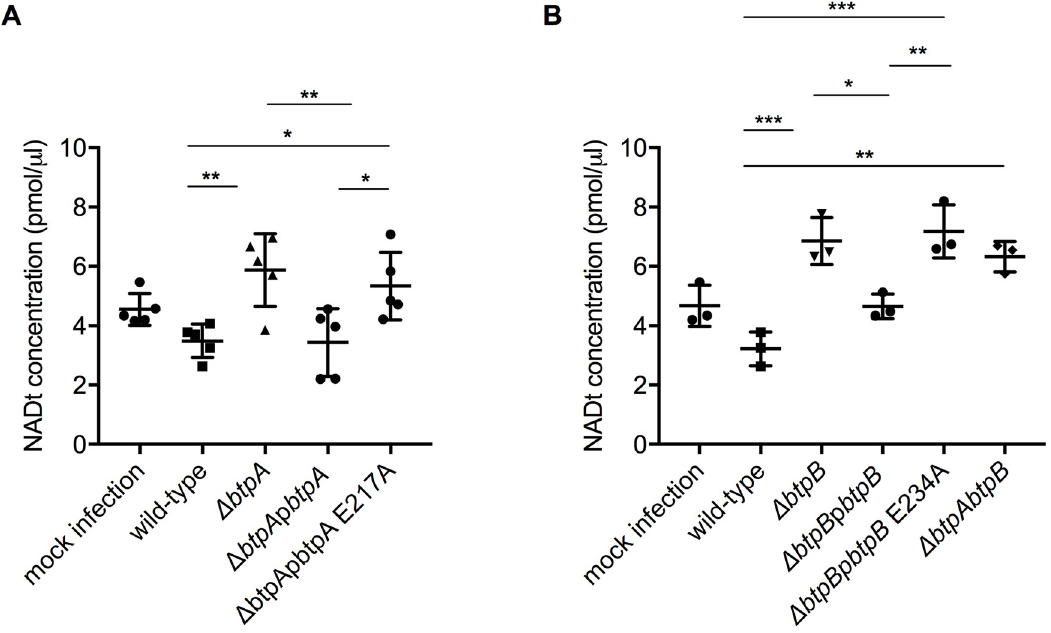
Fig 10. B . abortus TIR domain-containing proteins control intracellular total NAD levels during macrophage infection. (A) and (B) Immortalized bone marrow-derived macrophages (iBMDM) were infected for 48 h with either wild-type B . abortus or strains lacking btpA , btpB or both genes or complemented strains expressing btpA and btpB or the corresponding catalytic mutants. Mock infected cells are also included as a control. Total NAD levels were measured using a colorimetric assay and data correspond to means ± standard deviation from five (A) or three (B) independent experiments and statistical comparison was done with a one-way ANOVA test, with statistical significance indicated in the graph. Higher NAD levels in the infected cells than in the mock experiment are likely attributable to the fact that intracellular NAD levels from bacterial cells are added up to those of the cell line. In (A) for wild-type versus Δ btpA p = 0.0071, wild-type versus Δ btpA p btpA E217A p = 0.0476, Δ btpA versus Δ btpA p btpA p = 0.0058 and